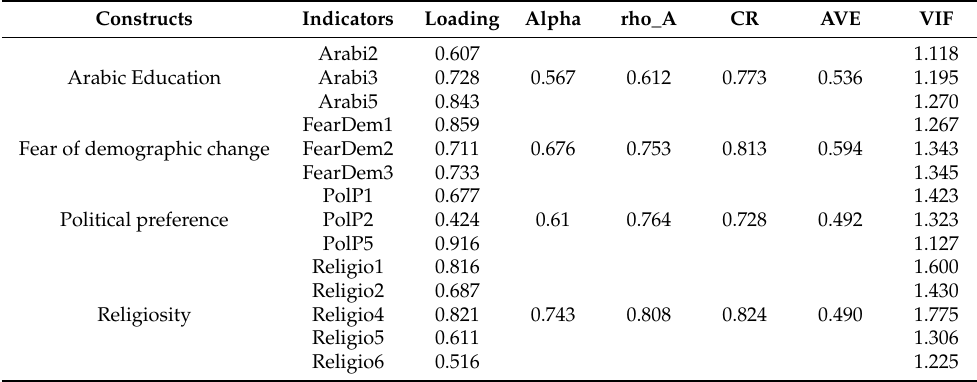
Table 2. Measurement specifications of the outer